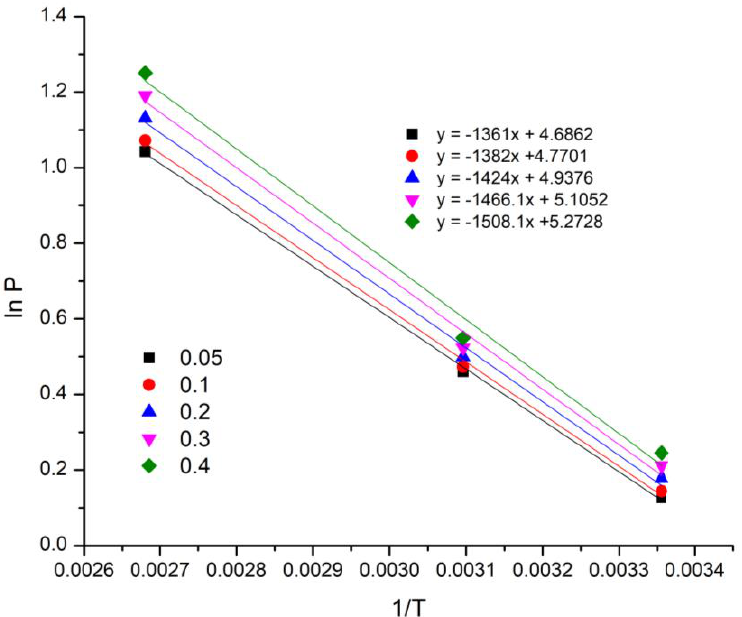
Figure 11. Isosteric ln P against 1/T where T is 298, 323, and 373 K for five different loadings, where n is in mmol/g.